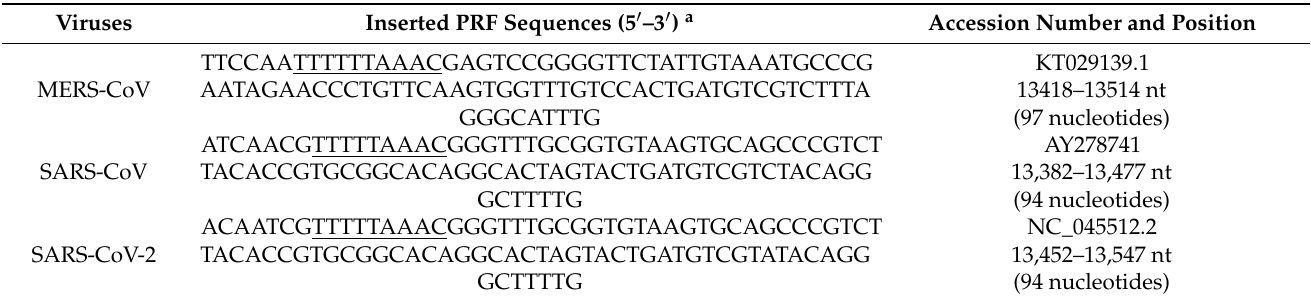
Table 1. Sequences of frameshift signals used in this study.